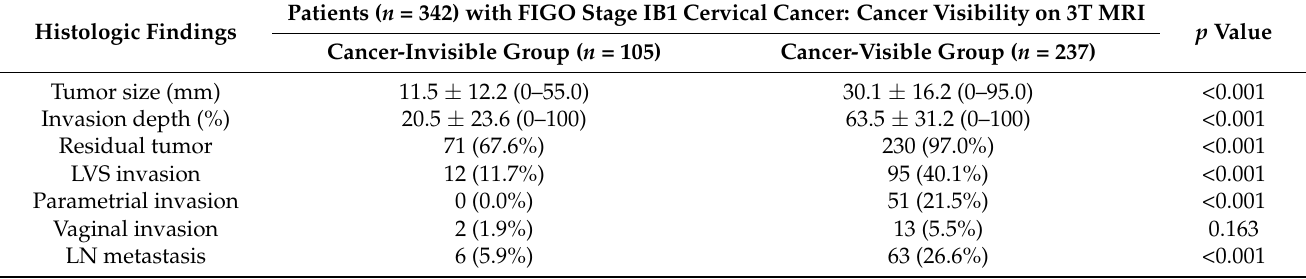
Table 2. Comparison of post-hysterectomy findings between the groups.